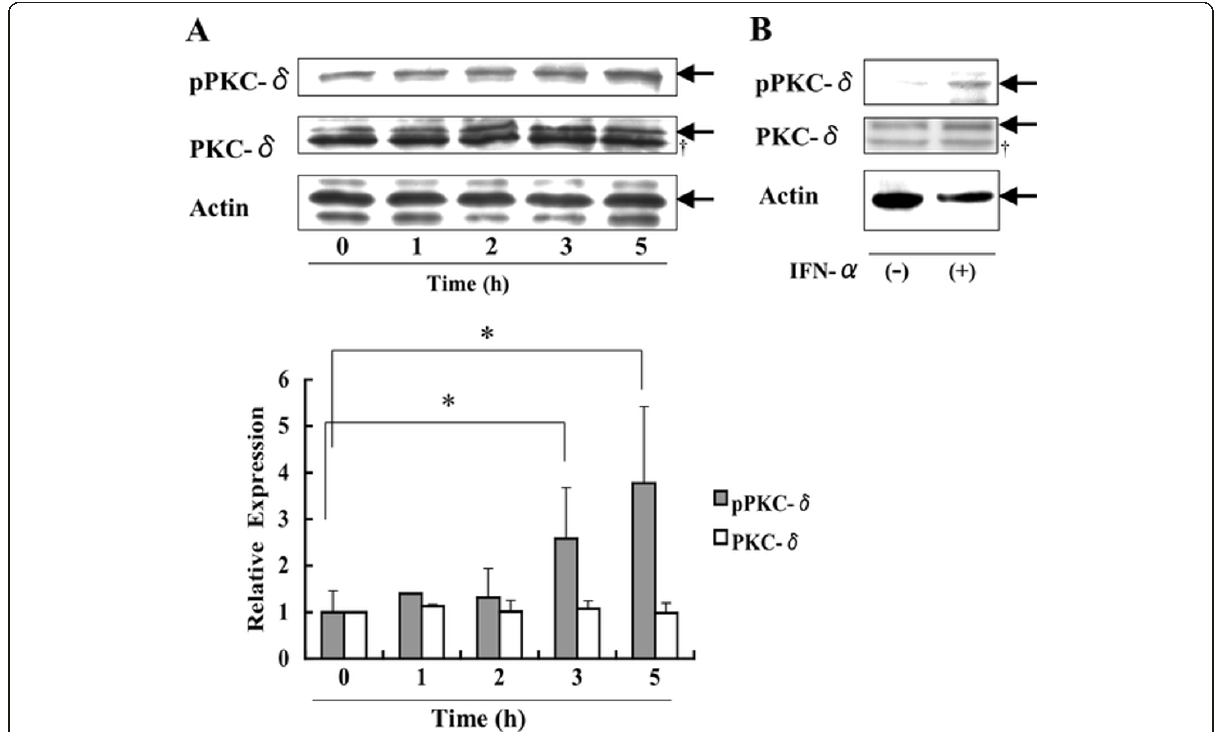
Figure 1 IFN- a induces phosphorylation of PKC- δ in Daudi and U266 B lymphoma cells . Daudi (A) and U266 (B) cells were cultured with 250 U/ml IFN- a , followed by Western blotting using Abs specific for pan- or phospho (Thr505)-PKC- δ . Arrows indicate specific bands for pPKC- δ , PKC- δ , and Actin, respectively. † , non-specific band. Expression of pan- or phospho-PKC- δ relative to actin is shown. Each point represents mean ± SD from five independent experiments. *Significantly different ( p < 0.05) from time